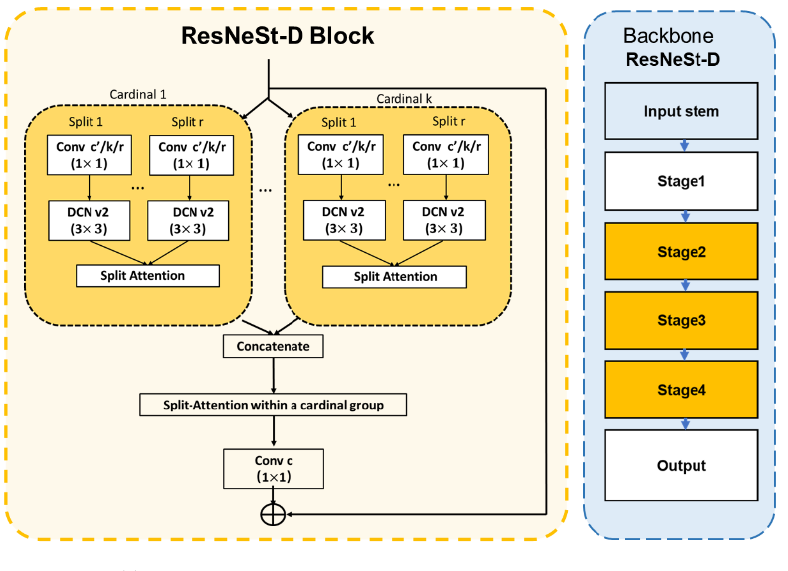
Figure 4. Backbone ResNeSt-D.